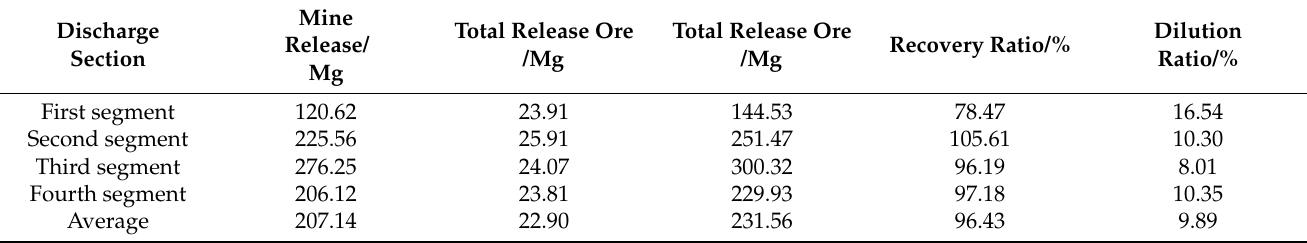
Table 3. Statistical data of 19 m × 20 m ore discharge